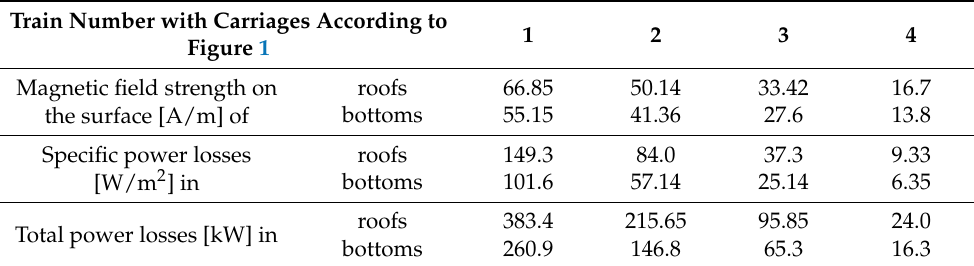
Table 4. Calculation of power losses in the steel sheets of carriage roofs and